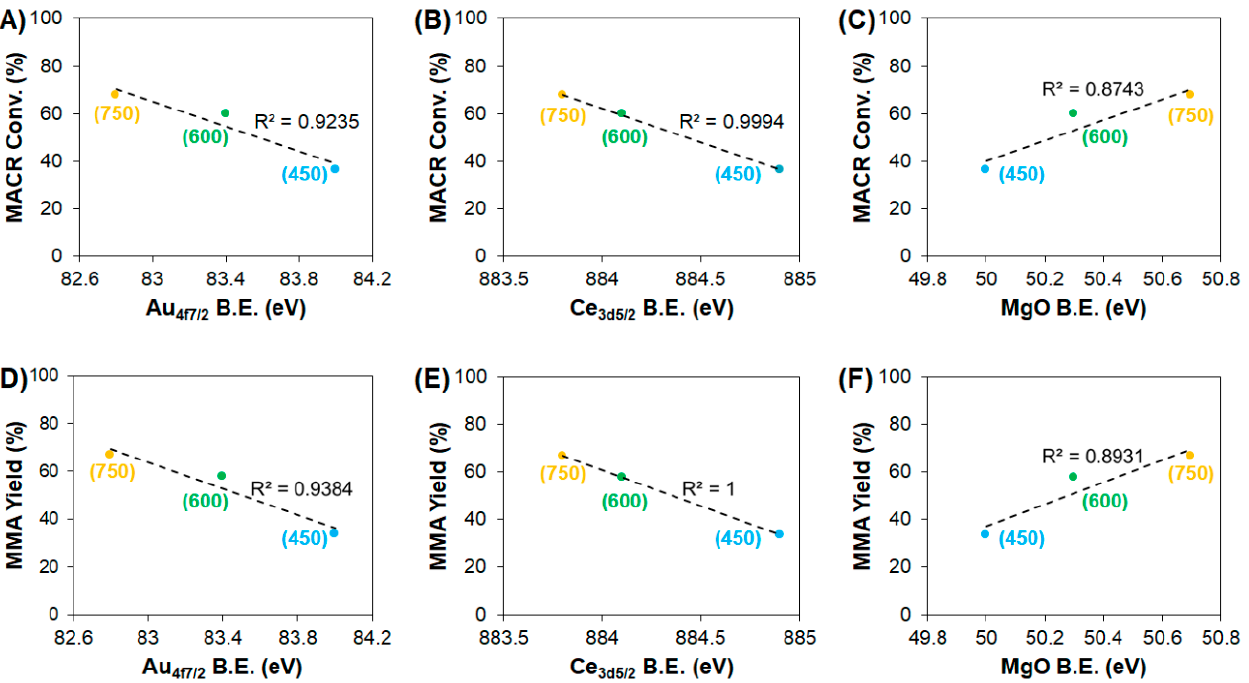
Figure 8. Correlations of ( A – C ) MACR conversion or ( D – F ) MMA yield with the binding energies of ( A , D ) Au 4f 7/2 , ( B , E ) Ce 3d 5/2 , ( C , F ) MgO, as summarized in the table in Figure 7.